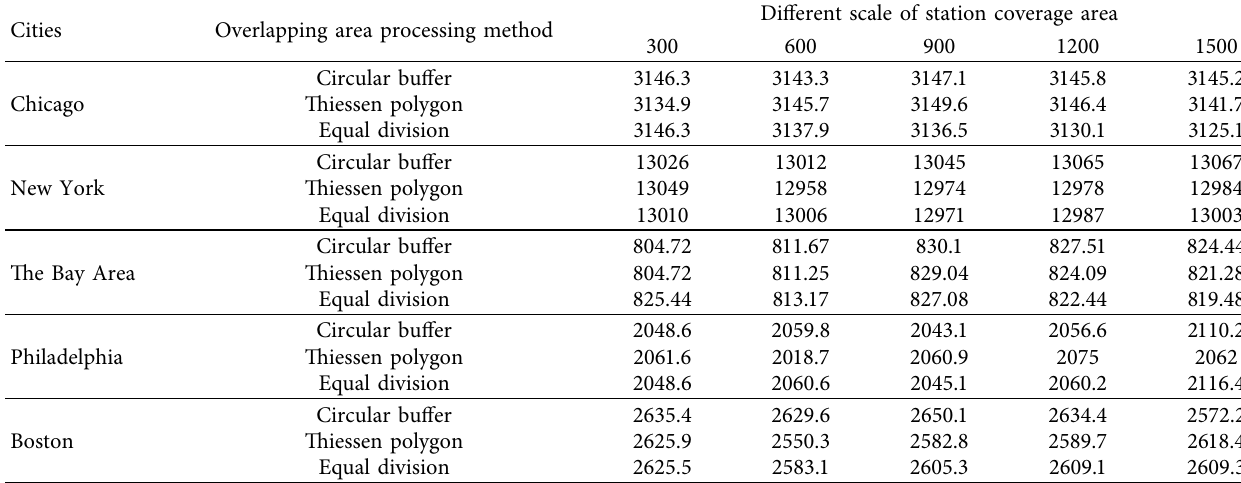
Table 13: Table of the AIC of negative binomial regression model in five cities.